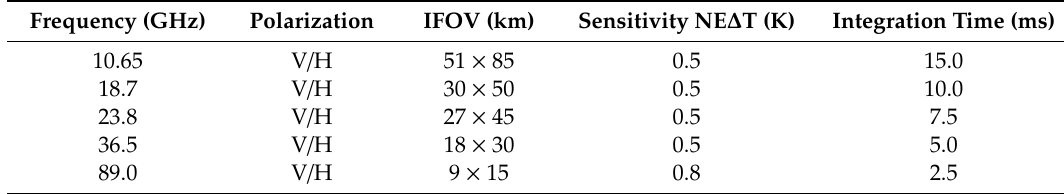
Figure 2. The scan geometry of the Fengyun-3C (FY-3C) microwave radiation imager (MWRI). Table 1. Performance of the FY-3C Table 1. Performance of the FY-3C MWRI.